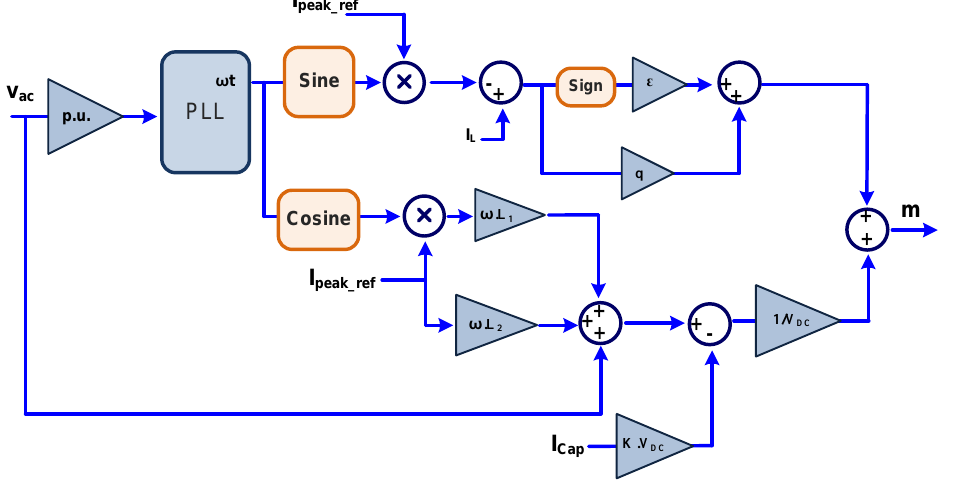
Figure 13. Proposed SMC control diagram strategy. 𝐼 𝐶𝑎𝑝 = 𝐼 𝐶 .